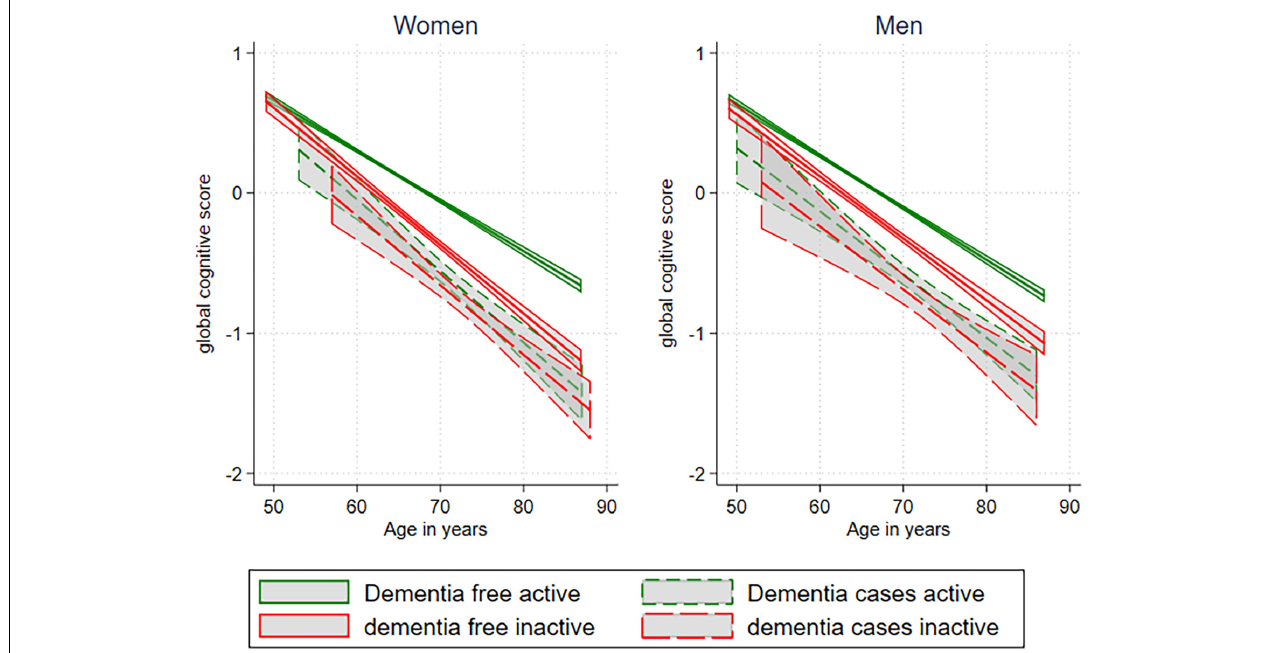
FIGURE 2 | Linear fit prediction plot for global cognitive score, stratified in activity, dementia, and sex.